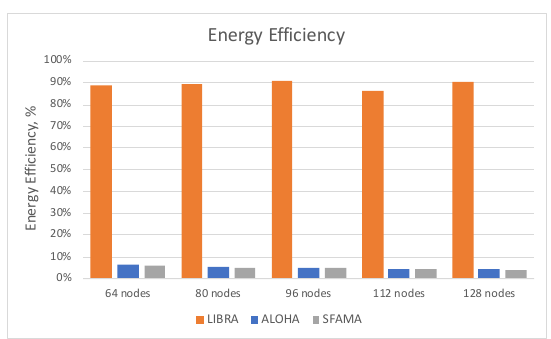
Figure 8. Energy